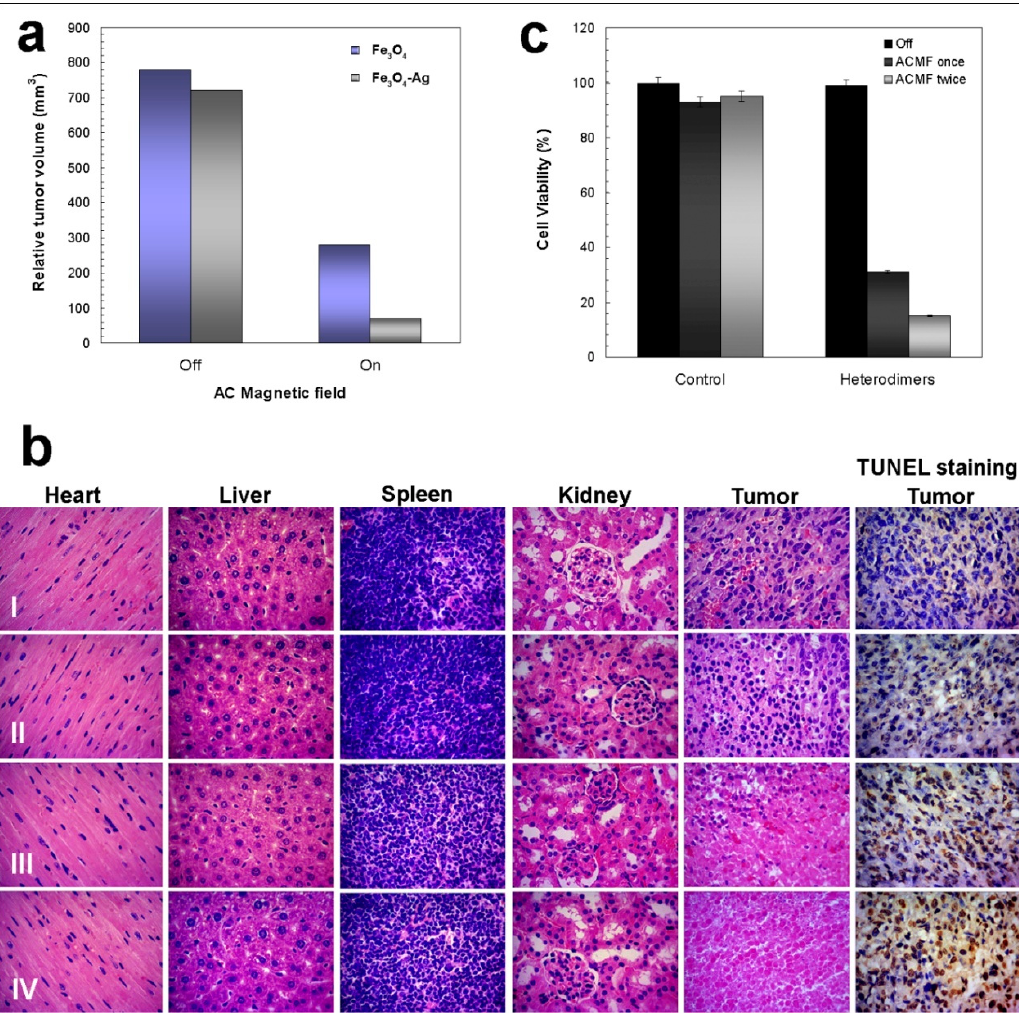
Figure 9. Therapeutic effects of heterodimers during magnetic hyperthermia in vivo antitumor effect of subcutaneous SMMC-7721 tumor in mice after seven-day treatment period by Fe 3 O 4 -Ag heterodimers ( a ). Data taken from reference [111]. Histological analysis of mouse organs and tumor on the seven-day after treatments for (I): Fe 3 O 4 nanoparticles without ACMF (II): Fe 3 O 4 -Ag heterodimers without ACMF (III): Fe 3 O 4 nanoparticles with ACMF, and (IV): Fe 3 O 4 -Ag heterodimers with ACMF ( b ). Reproduced with permission from [111], copyright (2017) Elsevier. Cell viability of the 4T1 cells after treatments by Fe 3 O 4 -GQD heterodimers ( c ). Data taken from reference [142].